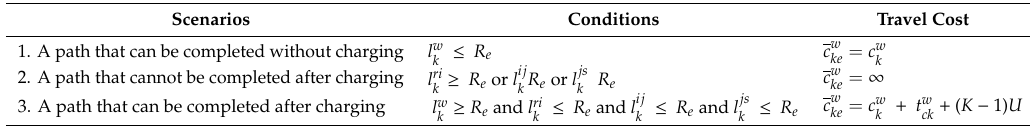
Table 1. Three travel paths of electric vehicles